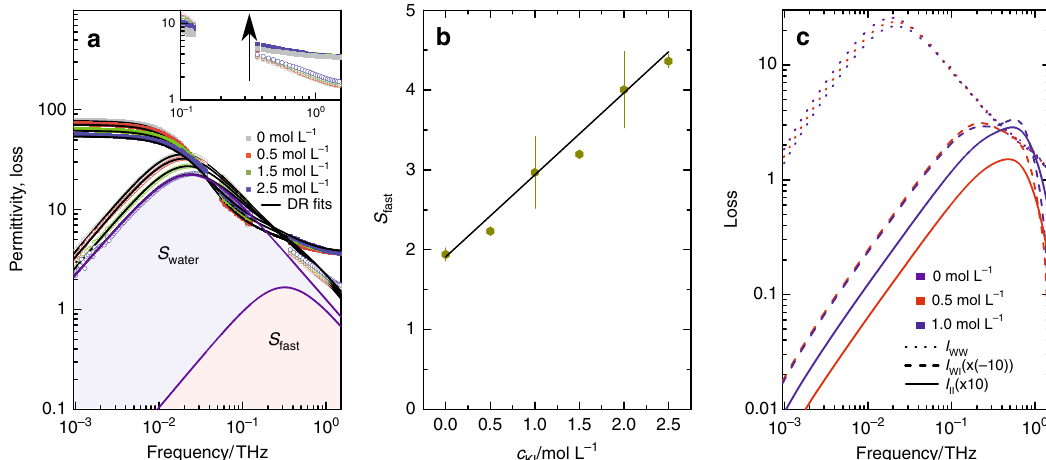
Fig. 1 Polarization dynamics of solutions of KI from experimental and simulated dielectric spectra. a Experimental dielectric permittivity ( fi lled symbols) and dielectric loss spectra (open symbols) of aqueous solutions of KI. Lines show fi ts using the relaxation model (see “ Methods ” section). The shaded areas show the contribution of the main water mode at 20GHz (light blue) and the fast mode at ~0.3 THz (light red) to the loss spectrum of the 2.5molL − 1 solution of KI. The 20GHz mode decreases in amplitude with increasing ionic concentration. In contrast, a zoom-in into the 0.1 – 1.5THz spectral range (see inset) reveals increasing spectral amplitudes with increasing KI concentration. Note that for visual clarity, the Ohmic loss (last term of Eq. (1)) has been subtracted. b The amplitude of the fast mode as obtained from fi ts to the experimental spectra as a function of salt concentration exhibits an increase with salt concentration. The solid line shows a linear fi t. Error bars correspond to the standard deviation within six independent measurements. c Dielectric loss of aqueous solutions of KI at concentrations of 0, 0.5, and 1 mol L − 1 as obtained from MD simulations (for details see Methods section). Dotted lines show the contribution of only water, solid lines the contribution of only the ions, and the dashed lines refer to the (negative) contribution from the correlation between ionic and water motion (see also Supplementary Fig.